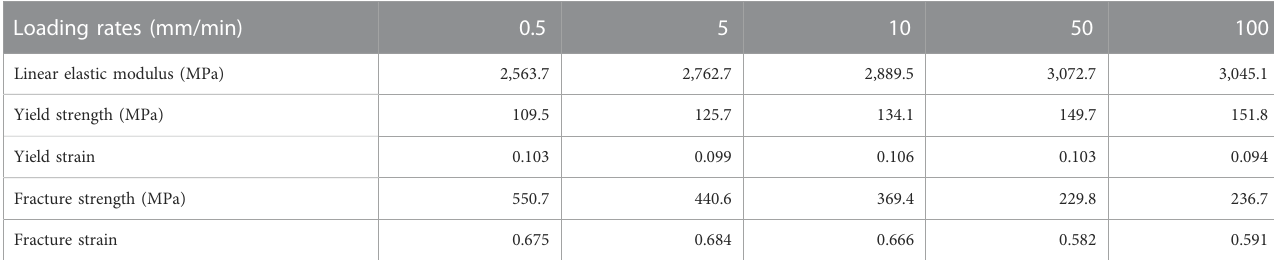
TABLE 1 The results of compression